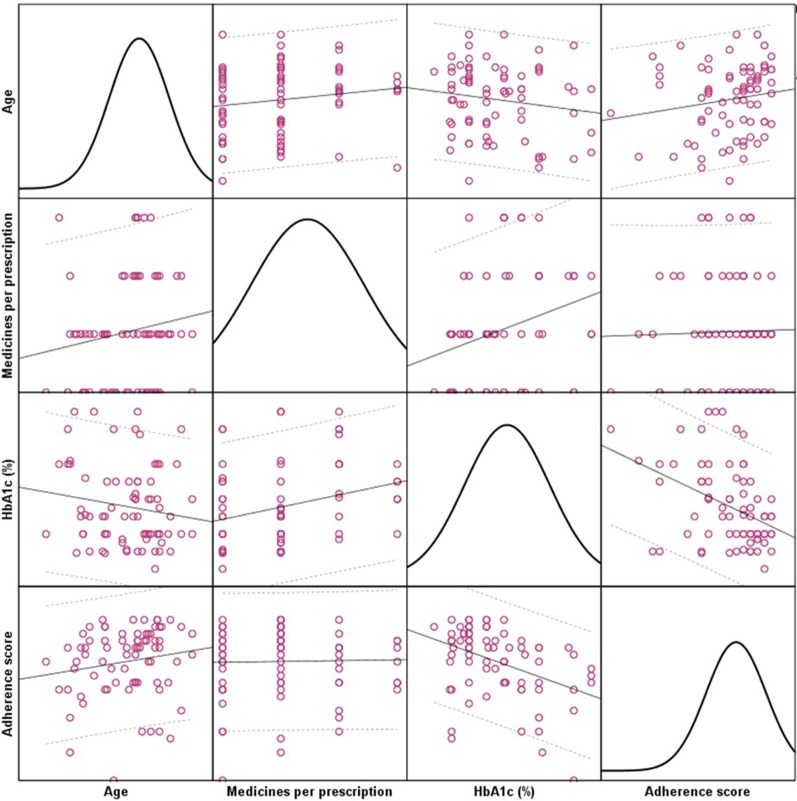
Correlations among age, medicines per prescription, HbA1c (%) and overall adherence score.